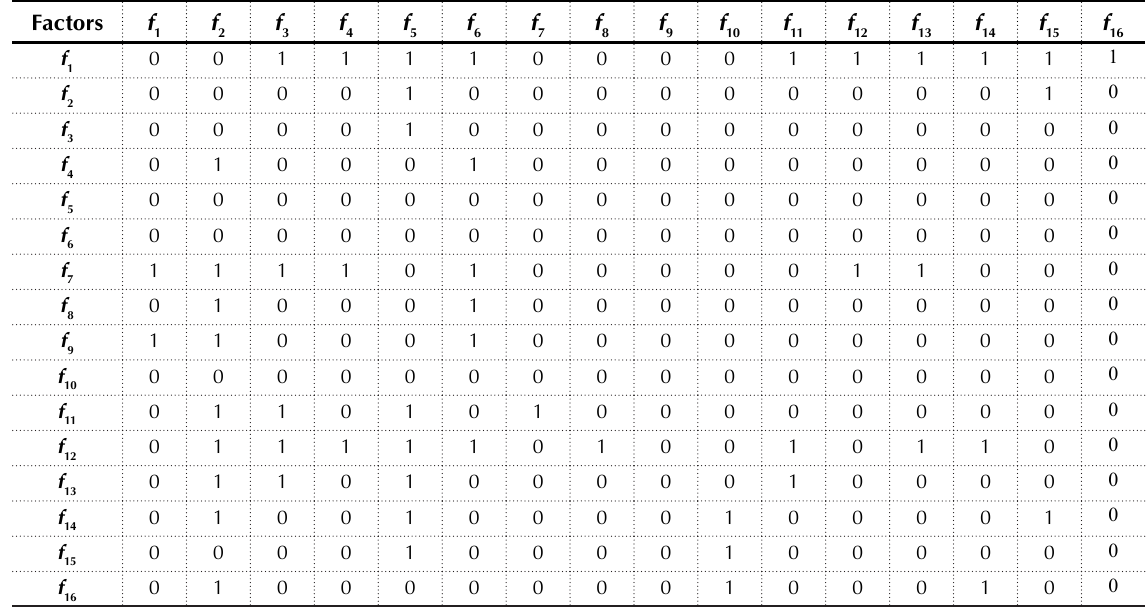
Table 1. Matrix of inter relations between the factors of influence on energy security of the enterprise